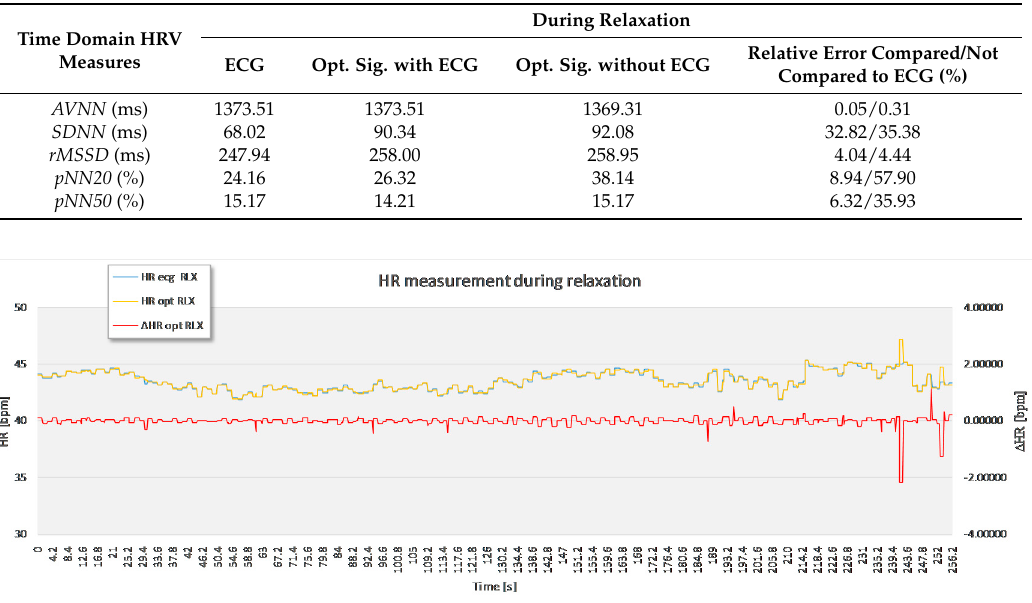
Table 9. Representative time domain values of HRV measurements in a 5 min data set.